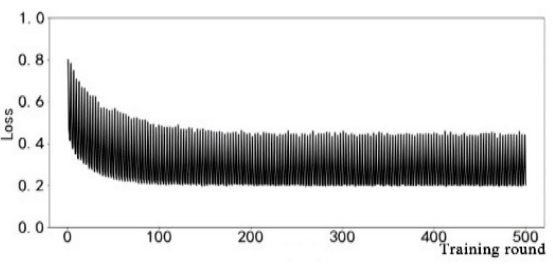
Figure 15. Expert-driven learning with a factor of ½.